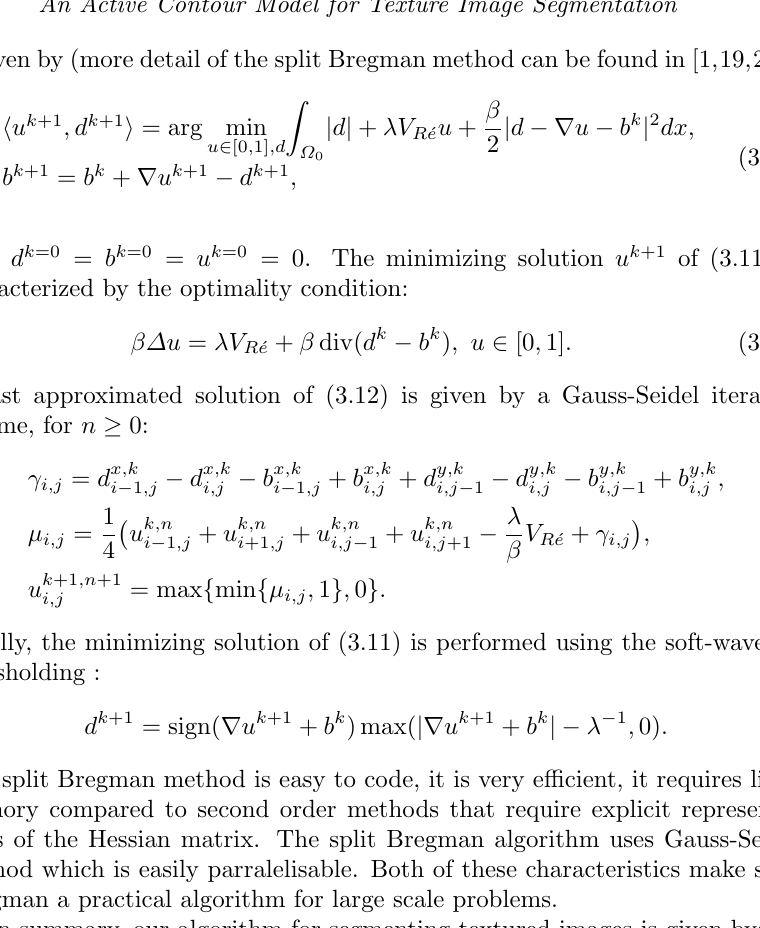
Algorithm 1. Our algorithm for segmenting textured